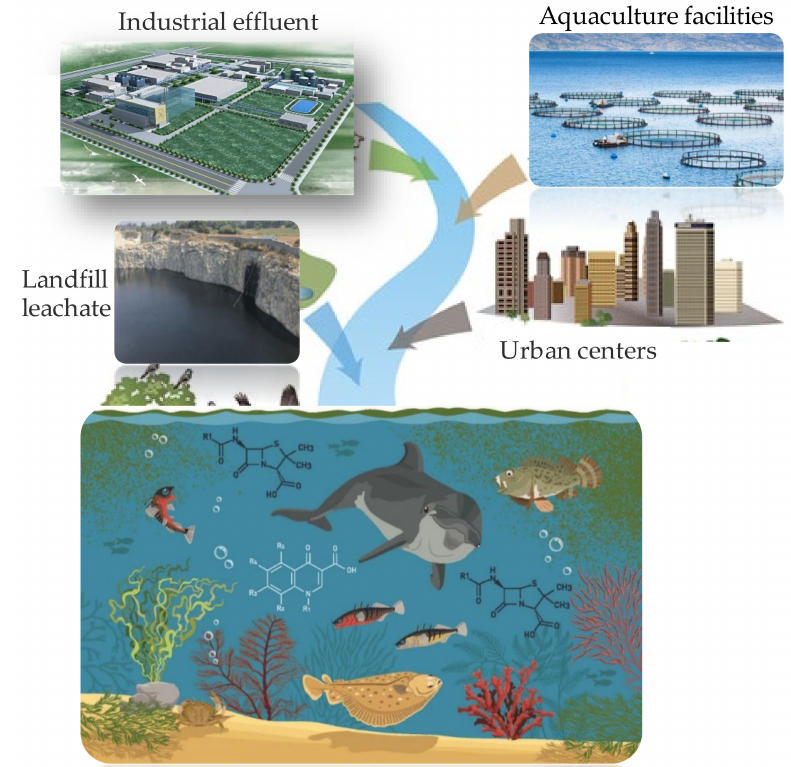
Figure 1. Typical sources PhaCs and PCPs aquatic systems.